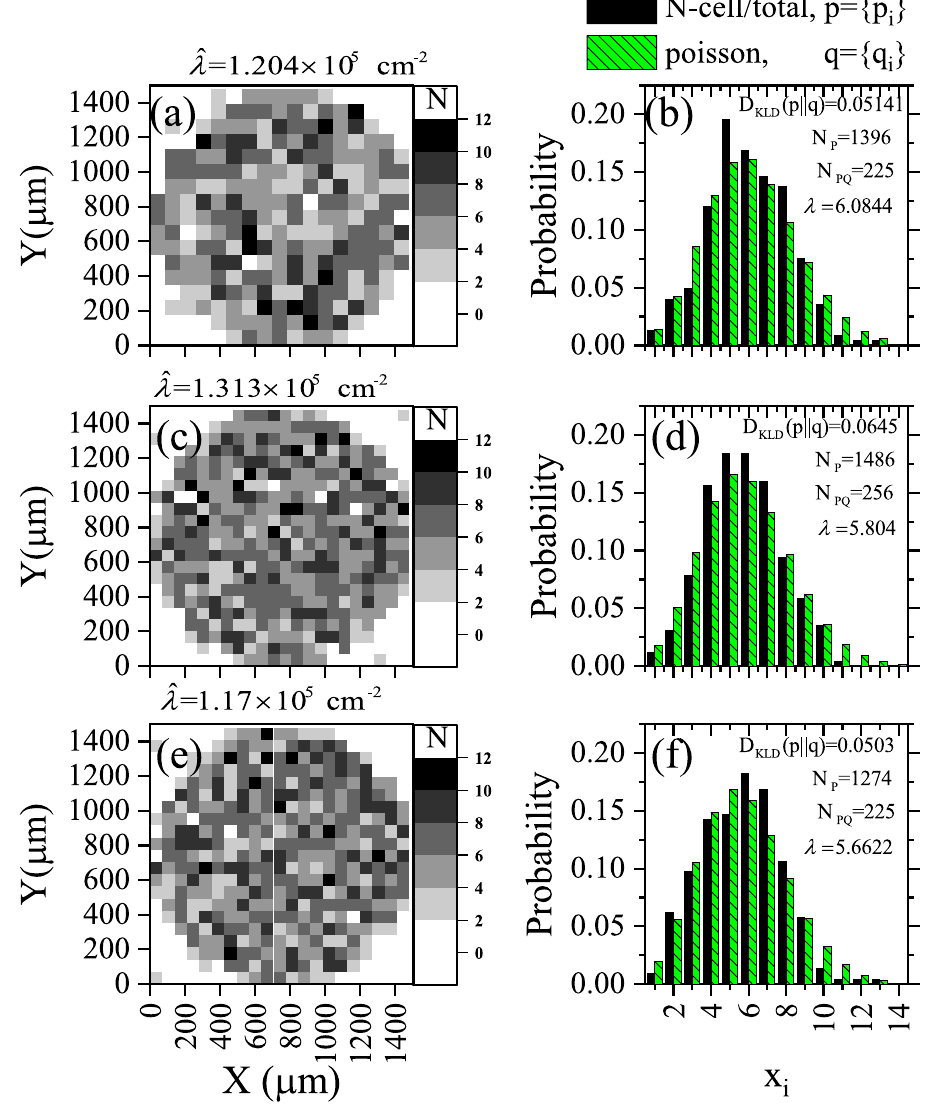
Figure 10. Comparison between heatmap for the investigated local track densities of samples ( a ) b4/1, ( c ) b4/2, and ( e ) b4/3 and its associated probability histograms ( b ), ( d ), and ( f ), respectively. Constructed as Figs. 7 and